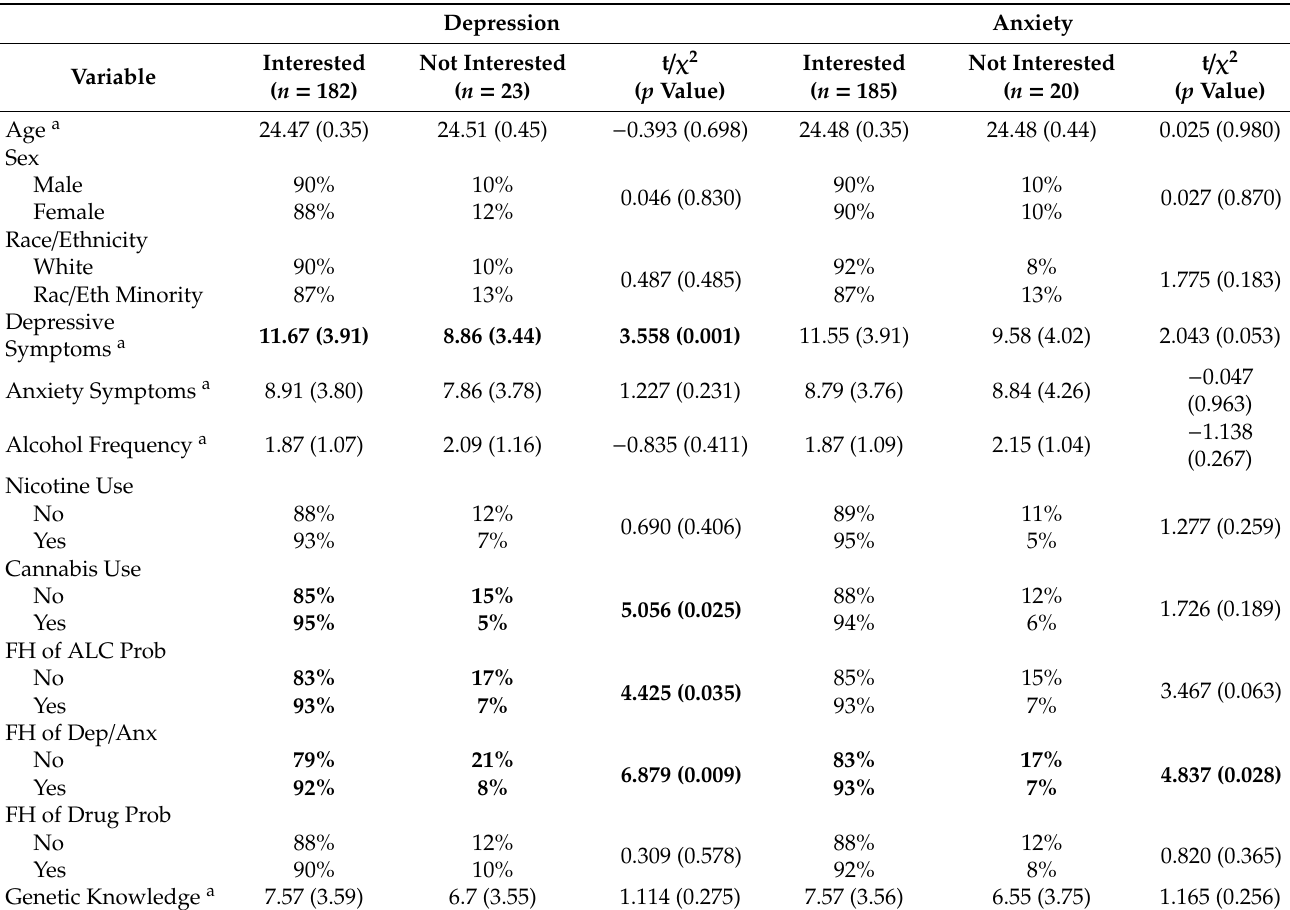
Table 5. Results of the chi-square and t -tests to compare demographic characteristics, substance use and mental health variables, family history, and overall genetic knowledge between those interested in receiving feedback for depression and anxiety and those not